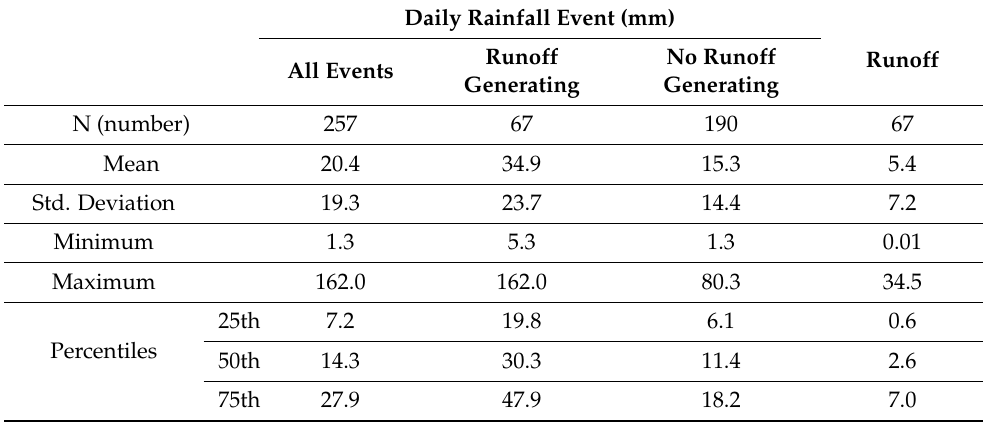
Figure 6. Monthly ( a ) rainfall; ( b ) continuous wet days (CWD); ( c ) continuous dry days (CDD)— 1974–2017. Table 3. Characteristics of rainfall and runoff at catchment scale